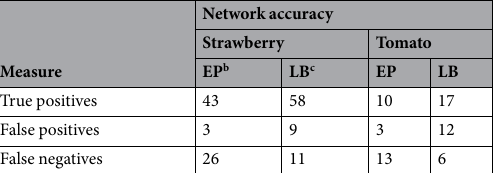
Table 2. Pooled relevant binary classification categories and neural network accuracy measures for goosegrass ( Eleusine indica ) detection in tomato ( Solanum lycopersicum ) and strawberry ( Fragaria × ananassa ) using two annotation methods on digital photography acquired in Central Florida, USA, in 2018 and 2019 a . a The neural network was the tiny version of the state-of-the-art object detection convolutional neural network You Only Look Once Version 3 (Redmon and Farhadi 2018). b EP = Entire plant annotation method. This refers to using a single, large square box to identify goosegrass within digital images. c LB = Leaf-blade annotation method. This refers to using multiple, small square boxes placed along leaf blades and inflorescence to identify goosegrass within digital images.